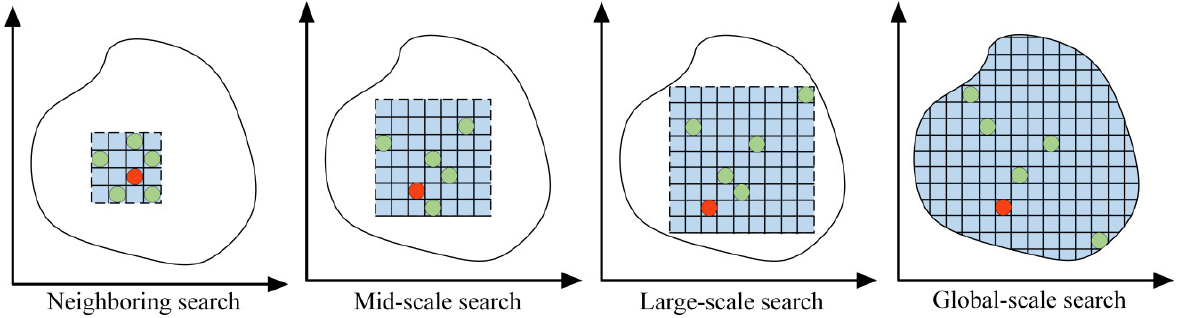
Figure 2. Illustration of four deterministic area searching methods.